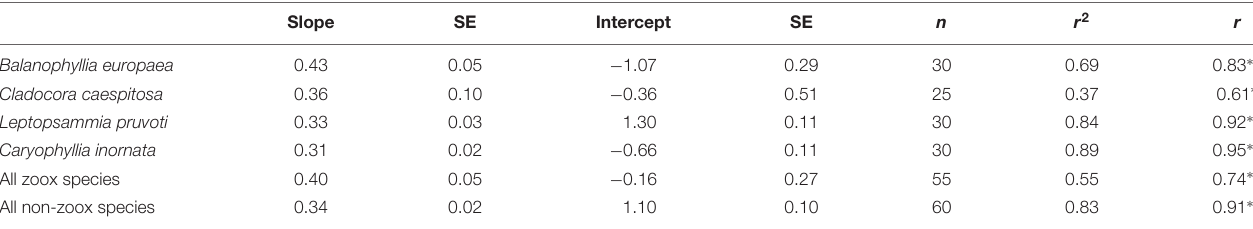
TABLE 2 | Linear regression and correlation analysis between skeletal δ 13 C and δ 18 O in the four individual species and for each group, zooxanthellate and non-zooxanthellate species. Slope SE